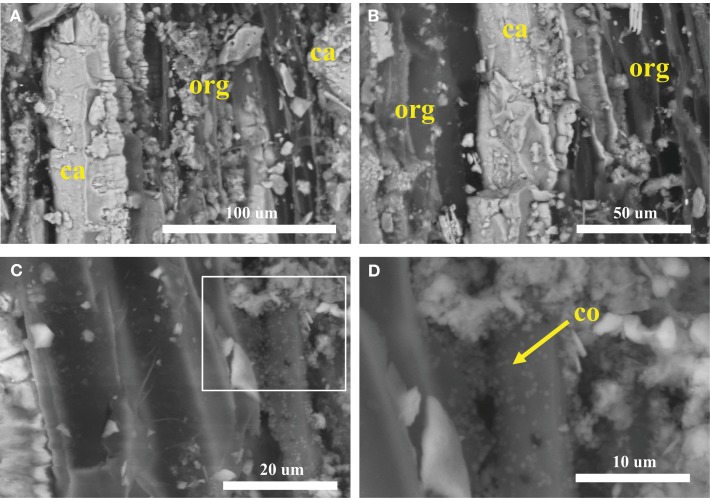
SEM of a plant root carbonate casing, viewed in cross section. (A,B) Cross sectional view of bands of organic rich (org) and calcium-rich (ca) material. (C) Biofilm layer. (D) Close-up of box in (C) containing putative coccoid cells.